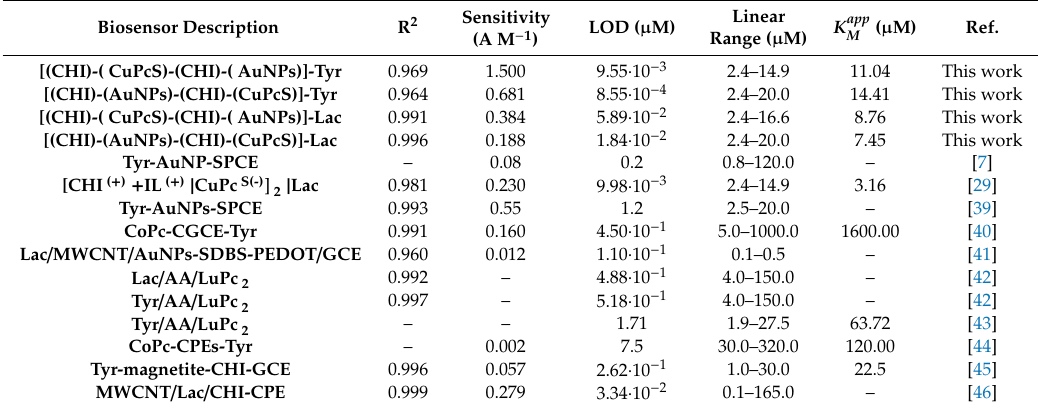
Table 1. Analytical parameters of biosensors combining similar